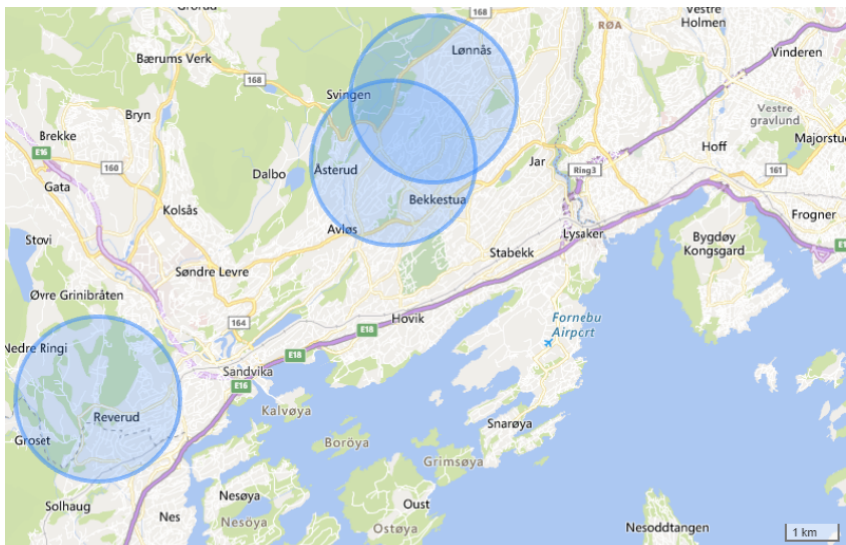
Figure 2. Example of assumed distances between homes and schools at 1.5 km